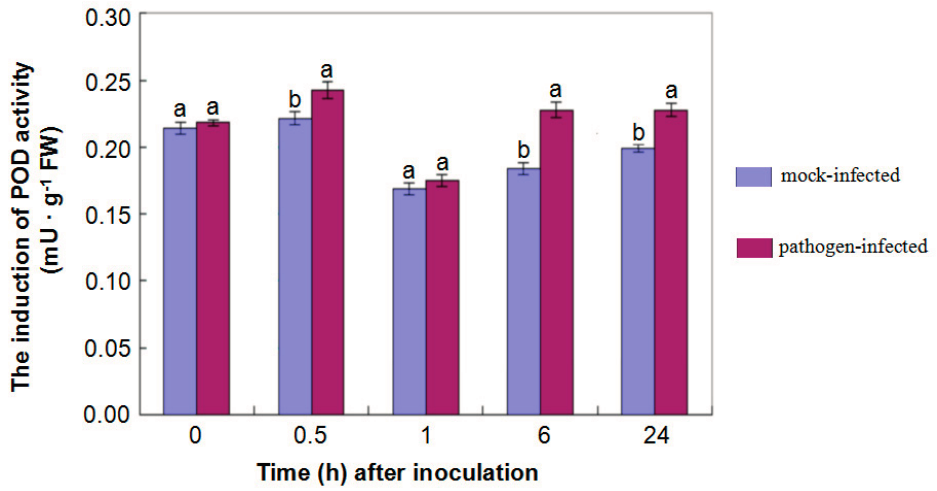
Figure 5. Induction of peroxidase (POD) activity in hypocotyls after inoculation . Data represented the induction of POD activity in the hypocotyls of G. thurberi seedlings in response to V. dahliae infection at 0, 0.5, 1, 6, 24 h after mock- and fungal- inoculation. Means significantly different from one another (at 0.5, 6, 24 h after inoculation) by Tukey ( α = 0.05) were shown as different letters on each